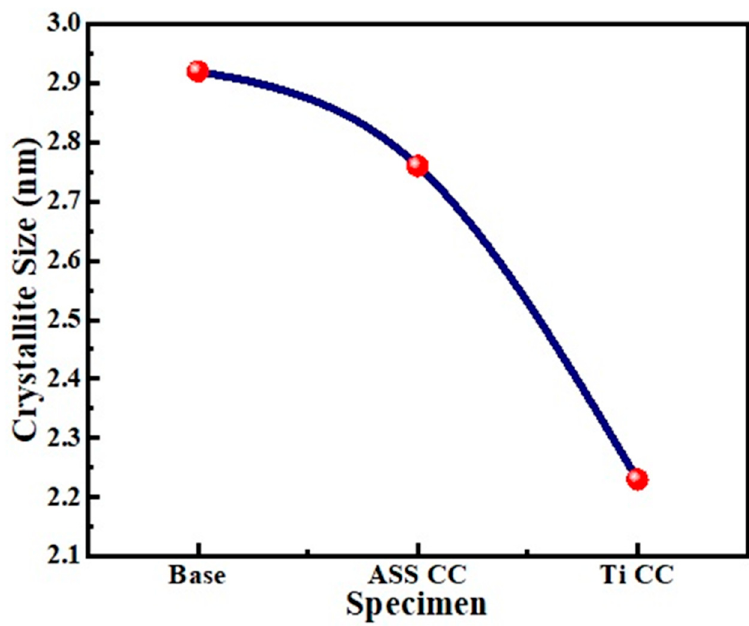
Figure 5. Change in crystallite size with specimen processed